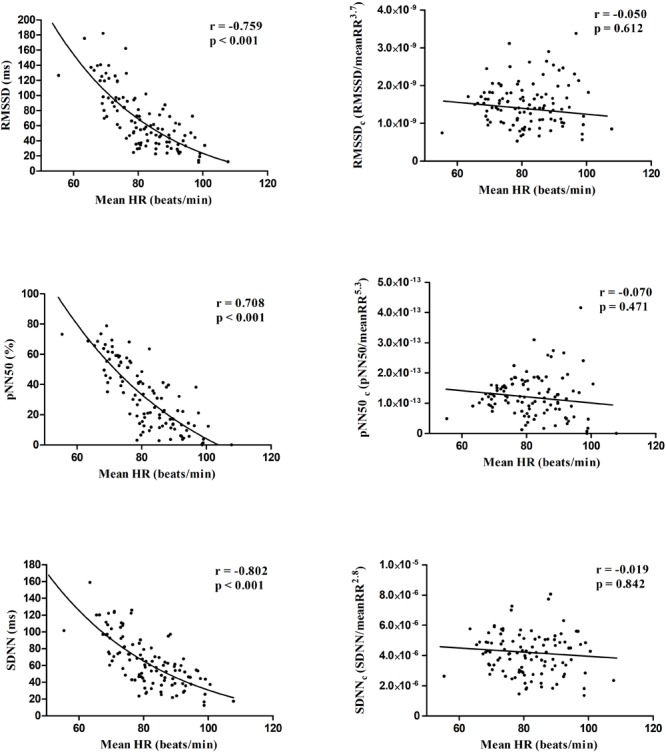
Scatter plots showing the Spearman correlations of time domain standard (left panels) and corrected (right panels) HRV parameters with mean heart rate.